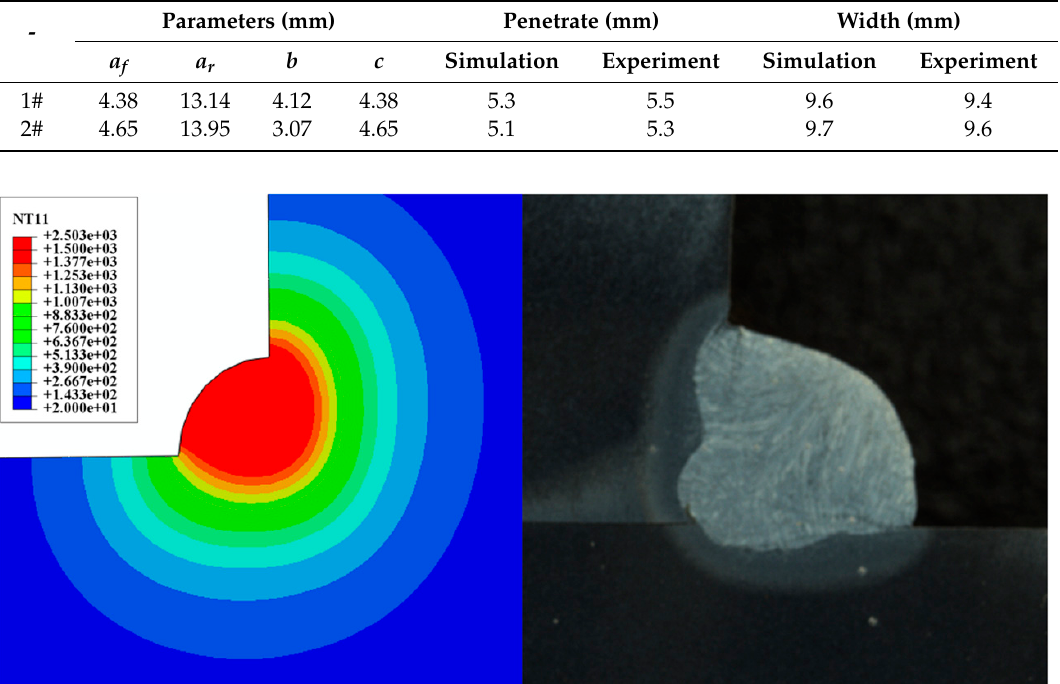
Figure 6. Comparison among calculated results and experimental results (Sample 1#).